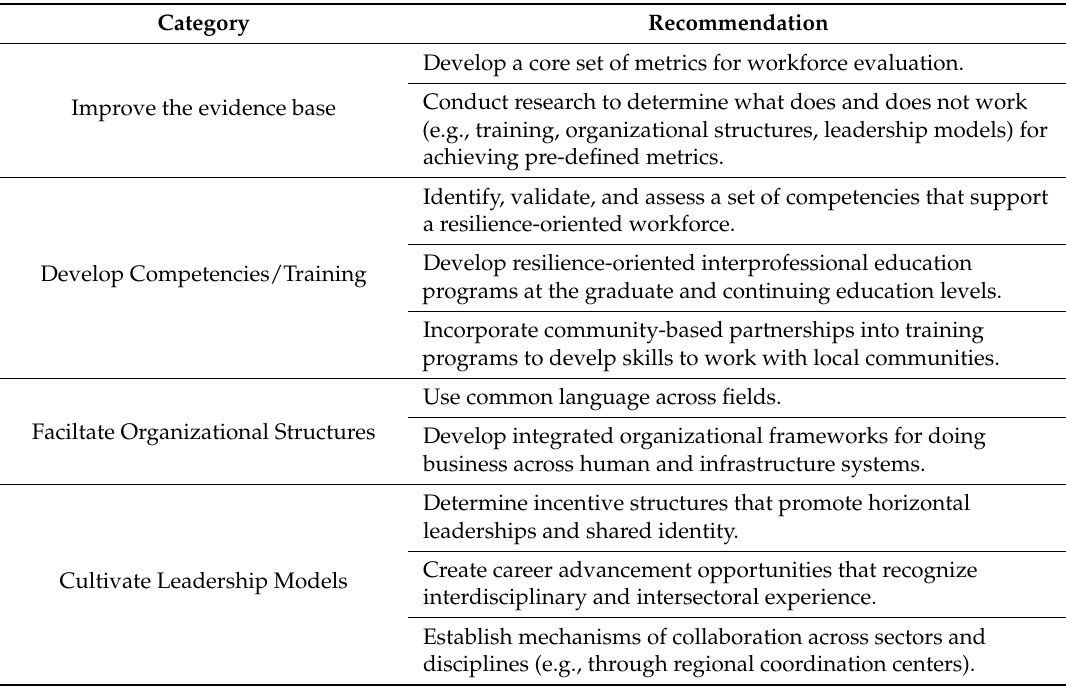
Table 2. Recommendations to move the resilience-oriented workforce